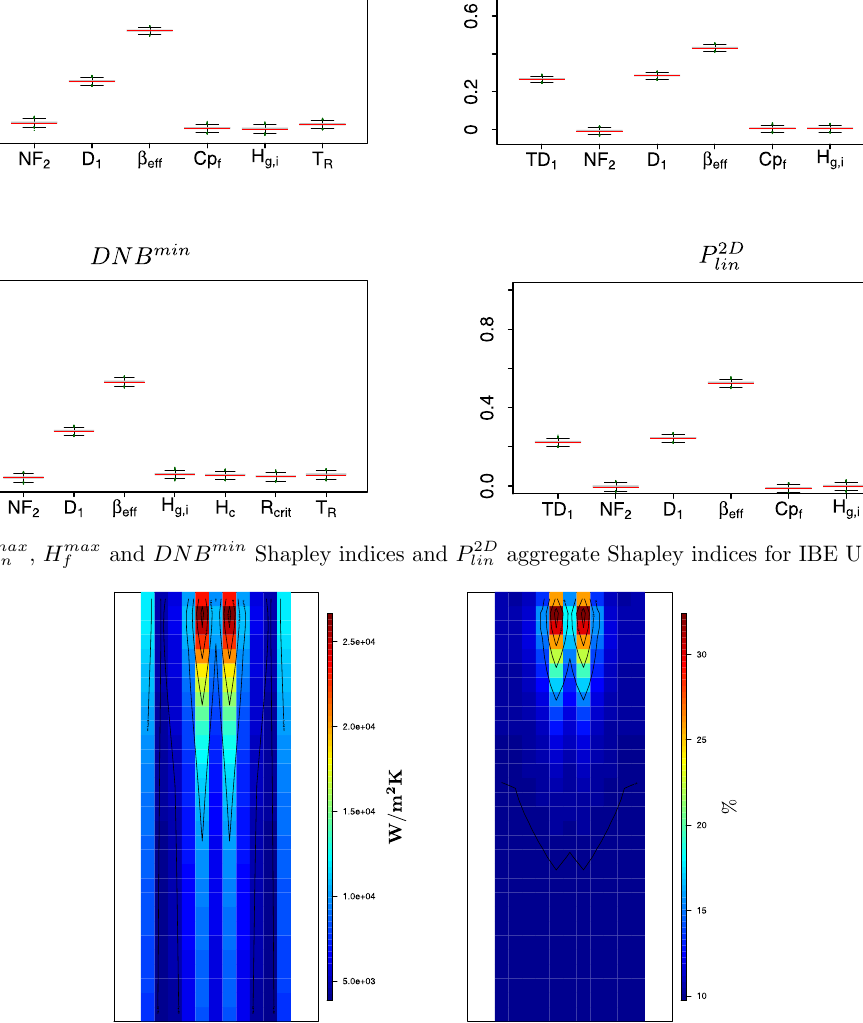
Fig. 15. H 3 D gap estimated mean and relative standard deviation in the axial cross-section for IBE UQ